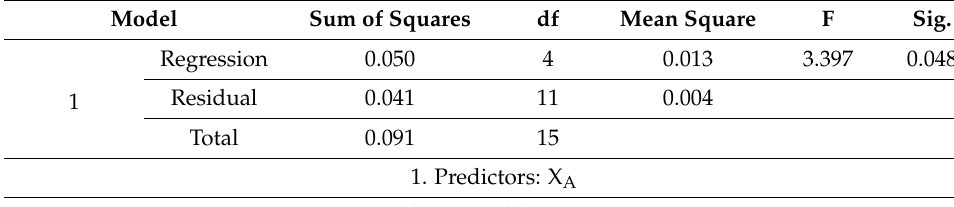
Table 4. ANOVA with four predictors.